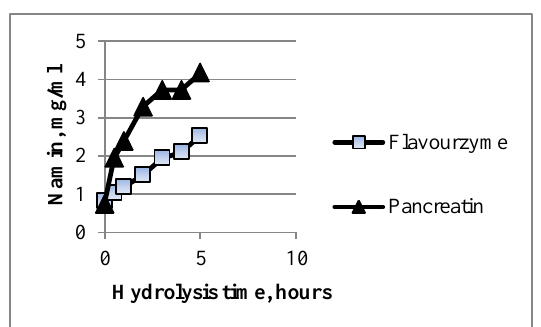
Fig. 6. The α-amino nitrogen content of Yeast